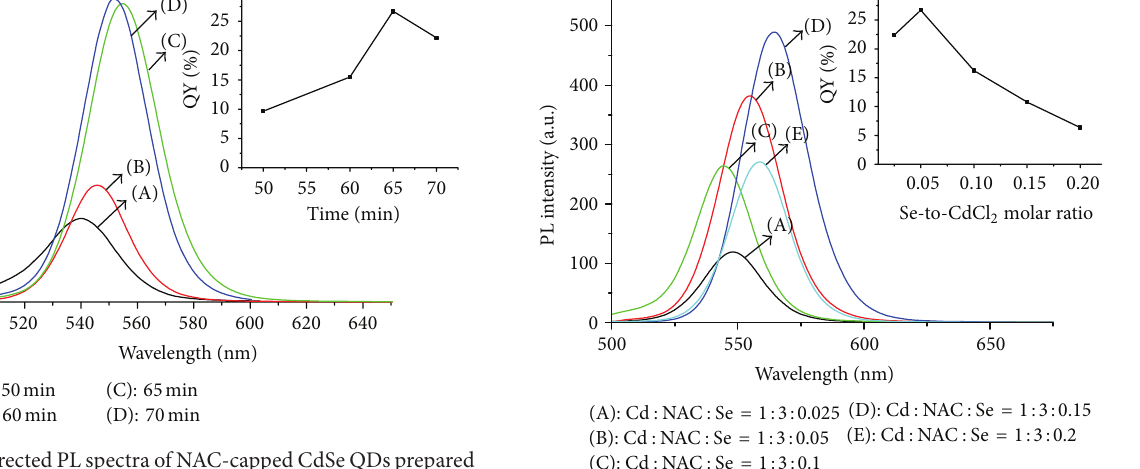
at different 𝑛 (Se)/1(Cd) values; the inset shows the QYs of these prepared